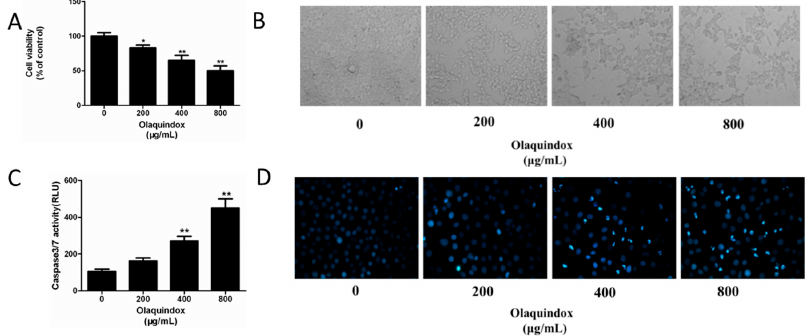
Figure 1. Effect of olaquindox on HEK293 cell viability and apoptosis. ( A ) Cell viability of 293 cells was estimated by MTT assays. Viability of control cells was set as 100%; ( B ) 293 cells were observed under a Leica inverted light microscope (400×); ( C ) Cells were exposed to specified concentrations of olaquindox for 24 h. Caspase activities were separately determined by the Caspase-Glo ® 3/7 assay kit; ( D ) Cells stained with Hoechst 33342 were observed under an inverted fluorescence microscopy (400×). All data represents means ± SD from three independent experiments. * p < 0.05, ** p < 0.01, compared to the control group.